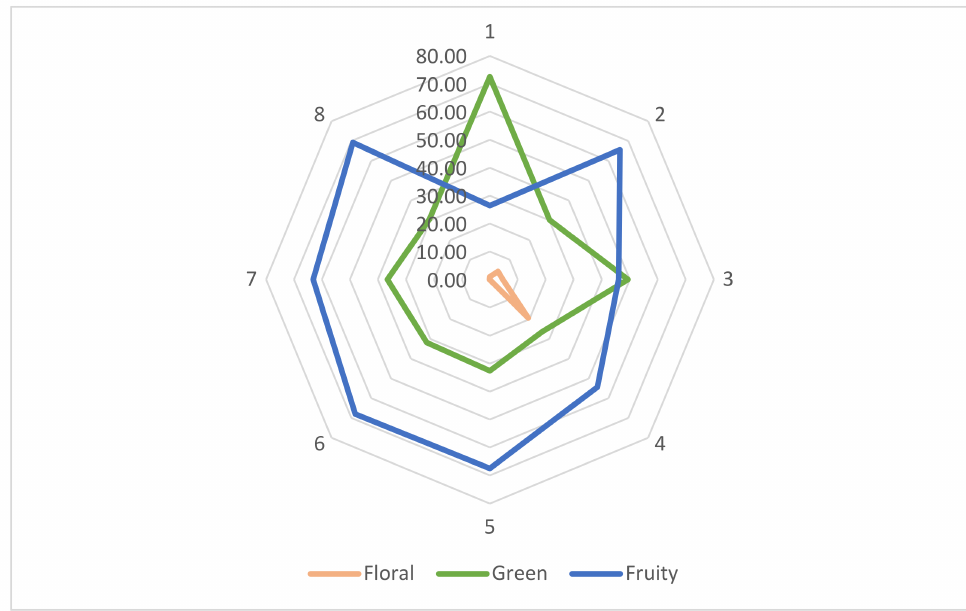
Figure 1. Sensory mapping of Capsicum specific aroma compounds: 1 (cv. Cherry/fresh); 2 (cv. Cherry/fermented); 3 (cv. Cayenne/fresh); 4 (cv. Cayenne/fermented); 5 (cv. Fatalii/fresh); 6 (cv. Fatalii/fermented); 7 (cv. Habanero/fresh); 8 (cv.